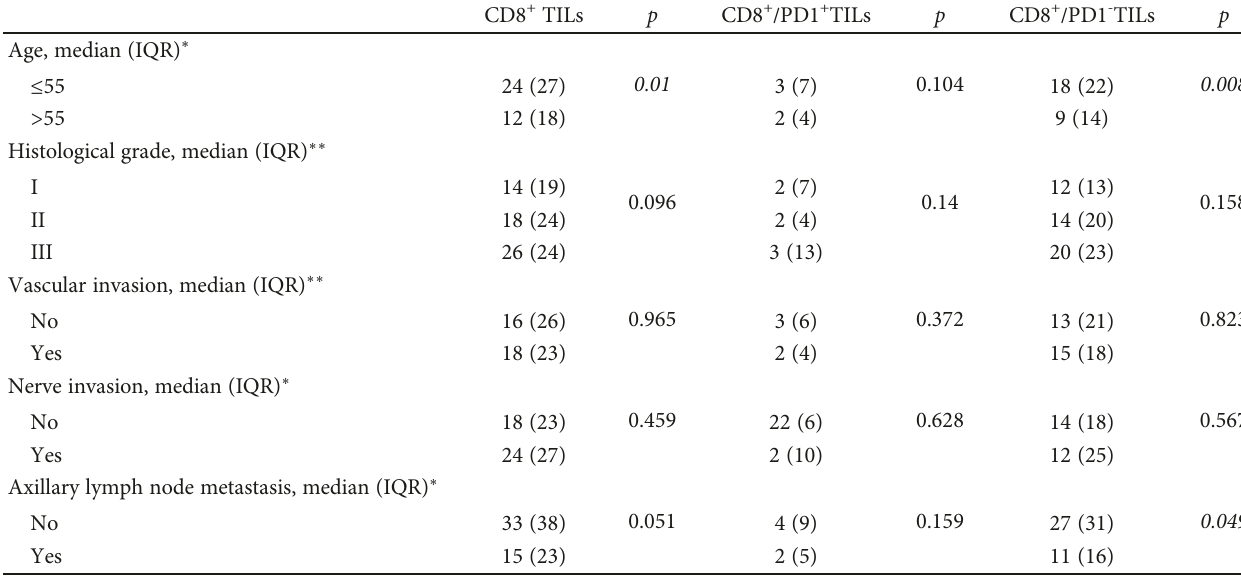
Table 3: The relationship between cell counts of CD8/PD-1 TILs and clinical